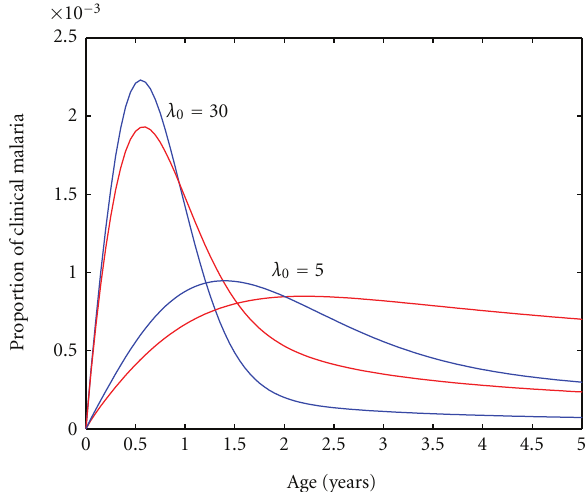
Figure 3: Mass drug administration (MDA) strategy applied in regions where P. falciparum (red) and P. vivax (blue) are equally prevalent. The initial parasite prevalence is equal for both P. vivax and P. falciparum as highlighted Figures 2(c) and 2(d) by V and F, respectively. Asymptomatic infections are treated at a constant rate so they, on average, last as long as a clinical case. The red solid and dashed lines display interventions with durations just below and above the deterministic elimination threshold, respectively, for P. falciparum . For P. vivax , the model indicates no deterministic elimination threshold. The blue solid line represents continuing the intervention for 18 years and then halting, under p 1 = p 2 = 0 . 25. The blue and red dot-dashed lines represent uninterrupted 20-year MDA campaigns.